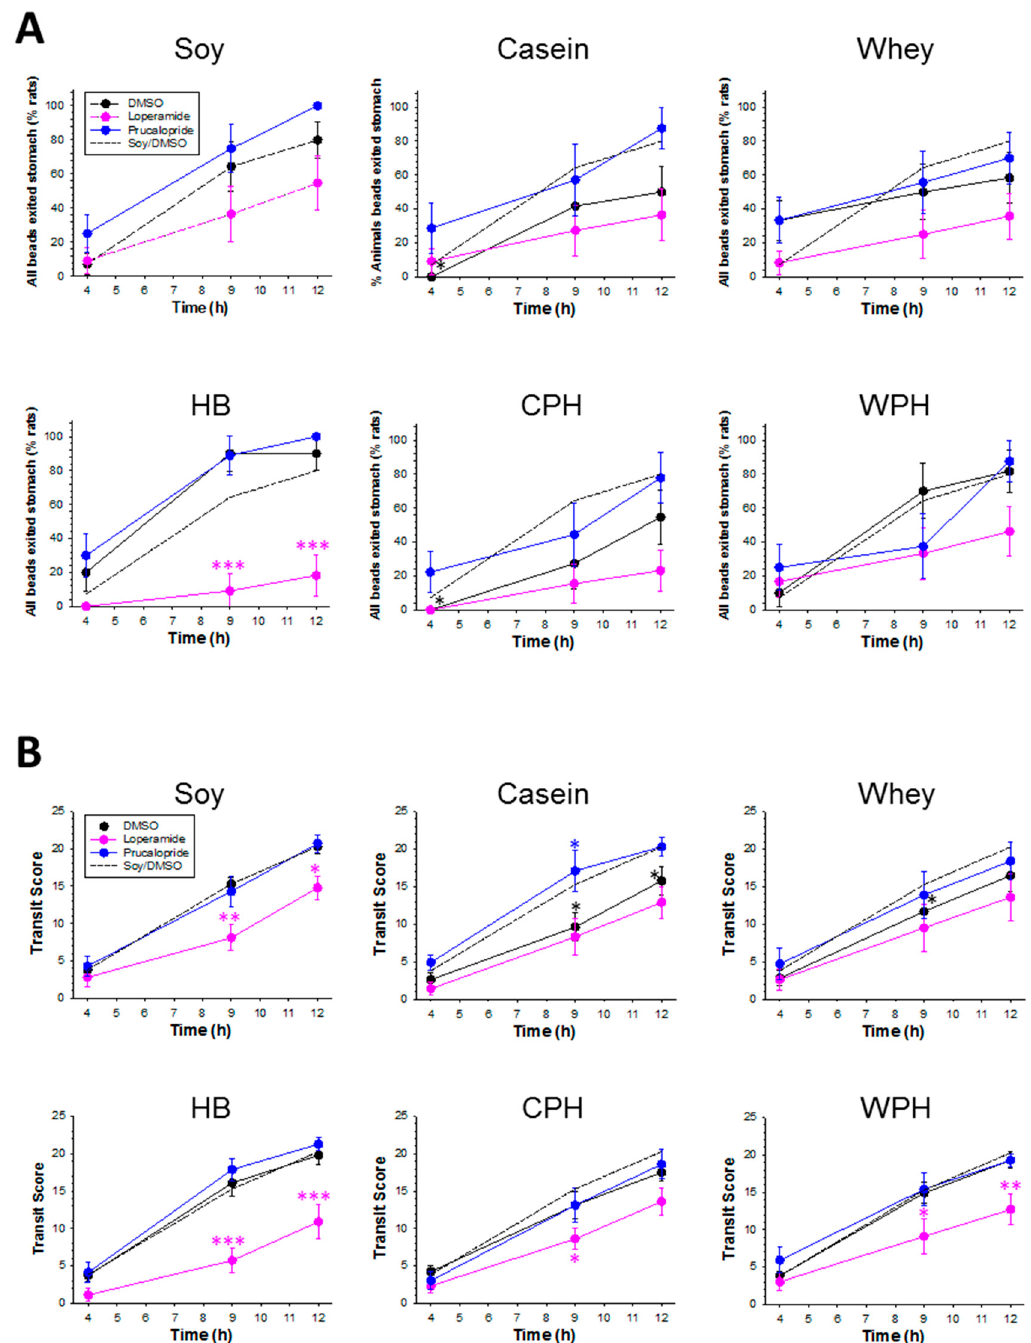
Figure 5. Effect of pharmacological modulators on dietary changes in GE and GI transit for animals treated with soy or milk protein diets. ( A ) The percentage of rats in which all beads had exited the stomach, and ( B ) transit scores for: soy, casein, hydrolyzed casein (CPH), whey, hydrolyzed whey (WPH), and hydrolyzed blend (HB). Asterisks indicate the significance of each treatment relative to controls (* p < 0.05; ** p < 0.01; *** p < 0.001). Data show mean ± SEM.